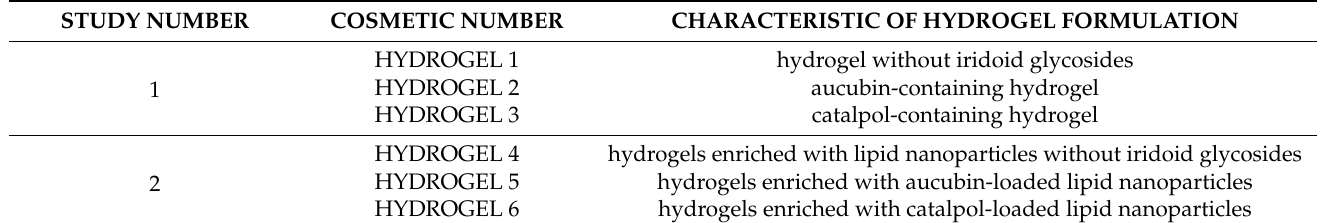
Table 2. List of hydrogel formulations tested within the framework of the in vivo study. STUDY NUMBER COSMETIC